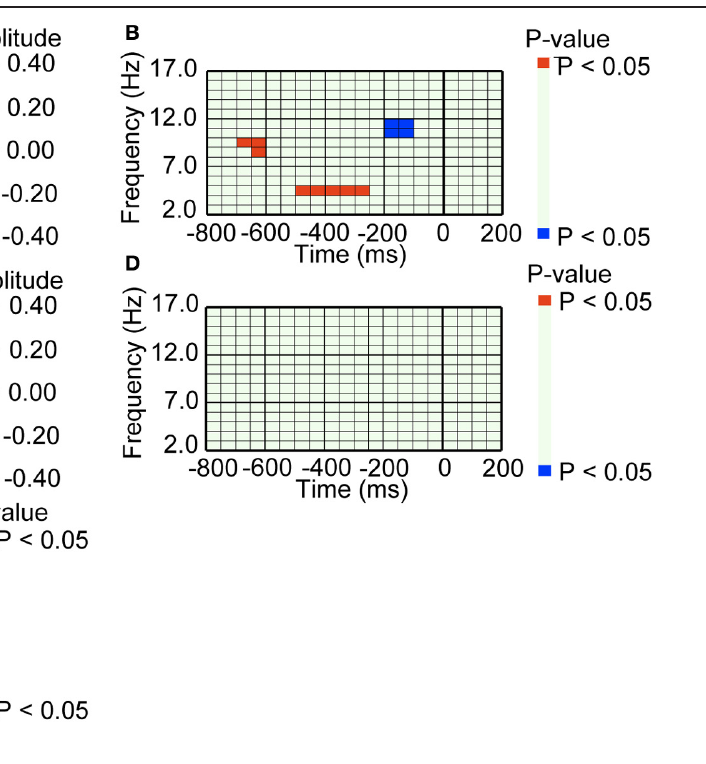
FIGURE 4 | A series of amplitude increase and decrease in occipital alpha band activity preceded saccade, when saccade was followed by perceptual switching. (A) Average waveform of the occipital recordings (O2) aligned with the pre-switch saccades that were followed by perceptual switching. The amplitude was Z-transformed, and the amplitude zero indicates baseline amplitude. (B) Statistical difference between average waveform aligned with the pre-switch saccades and baseline amplitude. The colors red and blue denote that amplitude was larger in average waveform or baseline amplitude, respectively ( P < 0 . 05). (C) Average waveform of the occipital recordings (O2) aligned with the no-switch saccades that were not